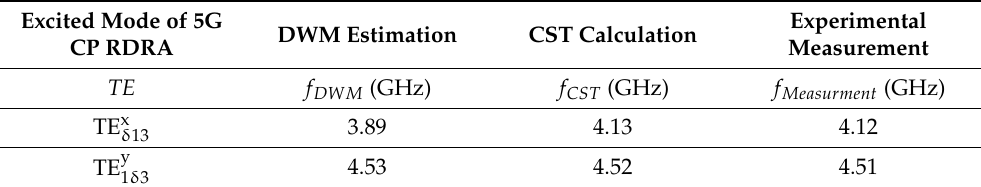
Table 3. Comparison between predicted, simulated, and measured mode frequencies of the CP 5G RDRA.